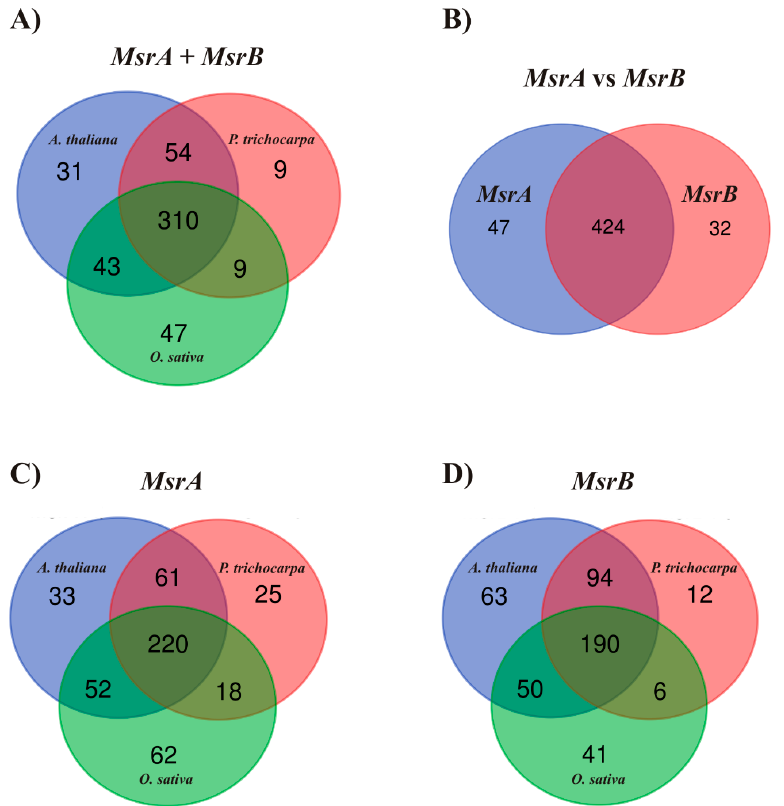
Figure 1. Venn diagrams comparing the transcription factor binding sites and responsive elements predicted for 30 homological genes of methionine sulfoxide reductase type A ( MsrA ) and B ( MsrB ) originating from the Arabidopsis thaliana , Populus trichocarpa , and Oryza sativa genomes. The three-set Venn diagrams show species-dependent ( A ), species-dependent and A-type-dependent ( C ), and species-dependent and B-type-dependent ( D ) interactions. The two-set Venn diagram shows type-dependent intersections ( B ), irrespective of species.